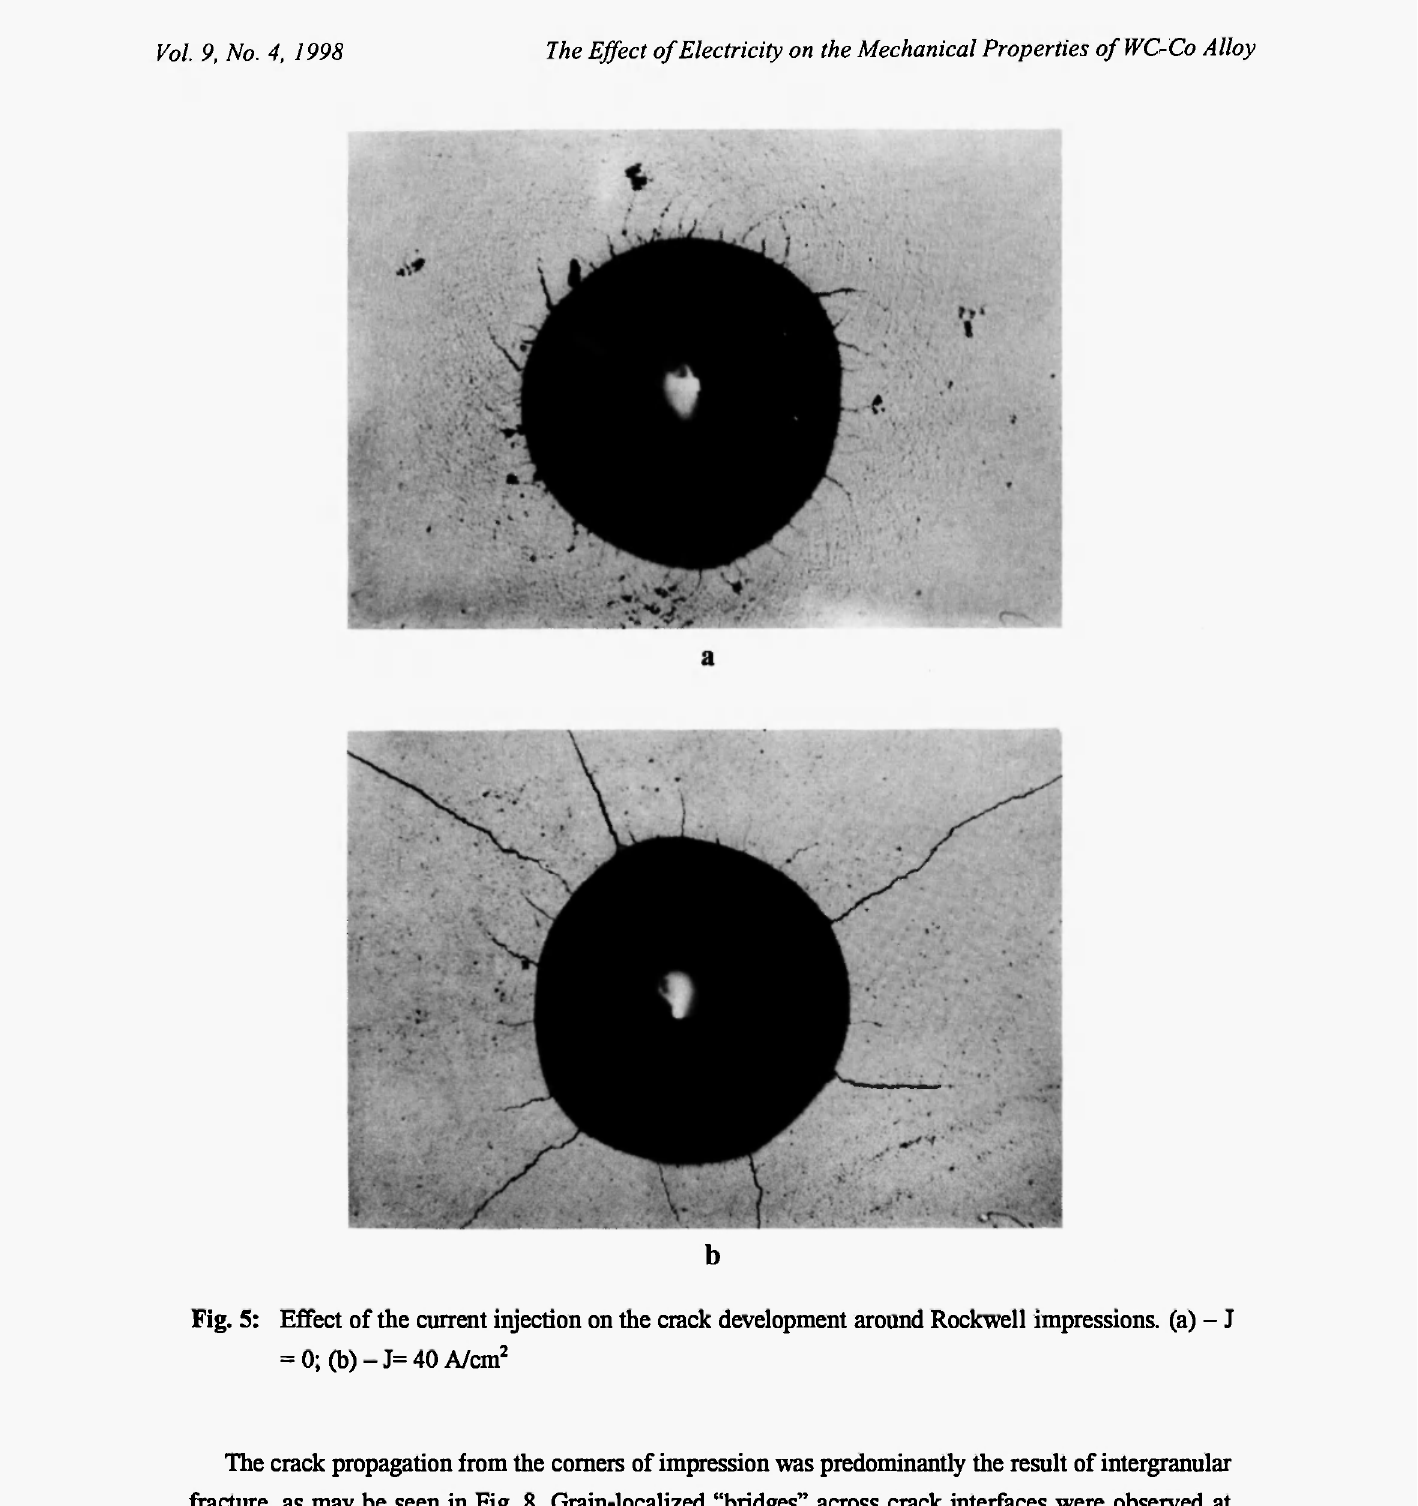
The crack propagation from the corners of impression was predominantly the result of intergranular fracture, as may be seen in Fig. 8. Grain-localized "bridges" across crack interfaces were observed at large distances from the impressions. There were ligaments across the crack interfaces and the new cracks adjacent to the primary crack on distances no more than one or two grain diameters. No carbide microcracks are visible around the crack